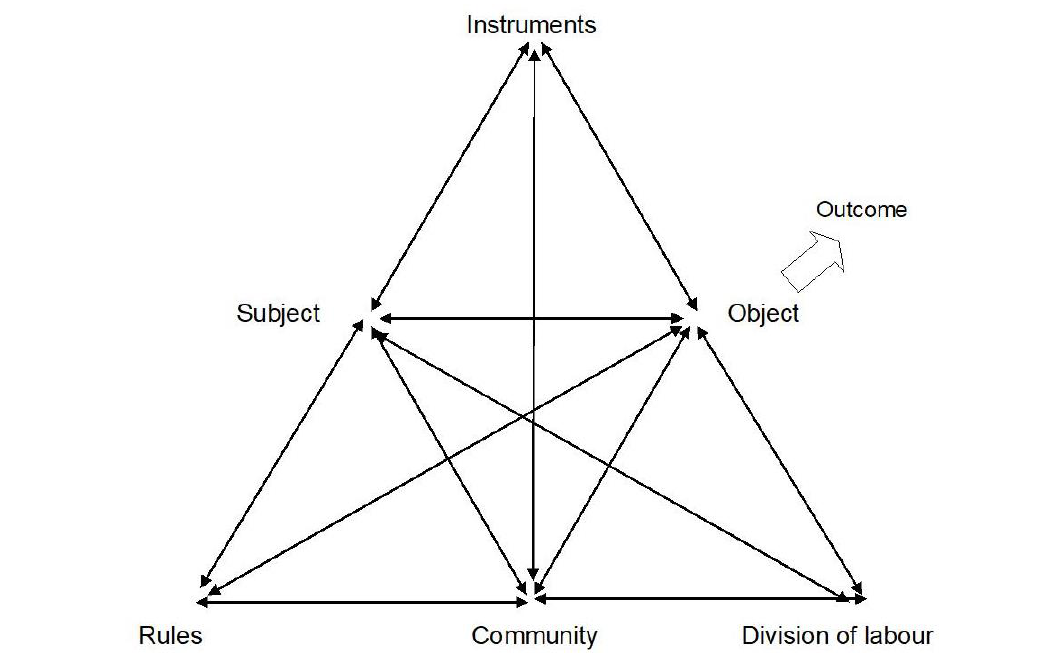
Figure 1. The meditational structure of an activity system (Source: Engeström, 1987, p.